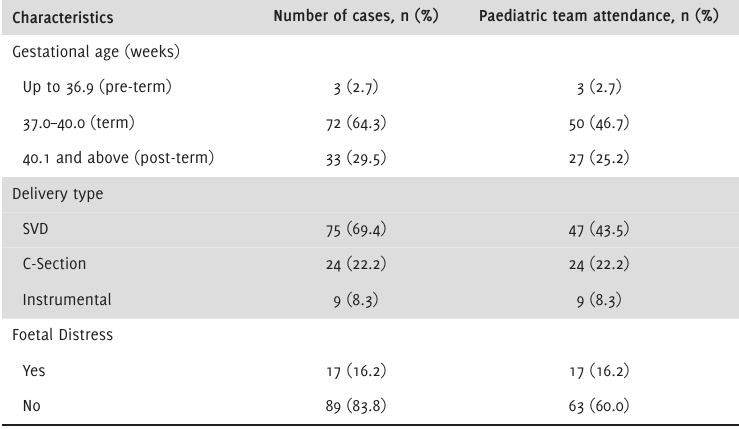
Table 1. Paediatric Team Attendance by Gestational Age, Delivery Type and Foetal Distress